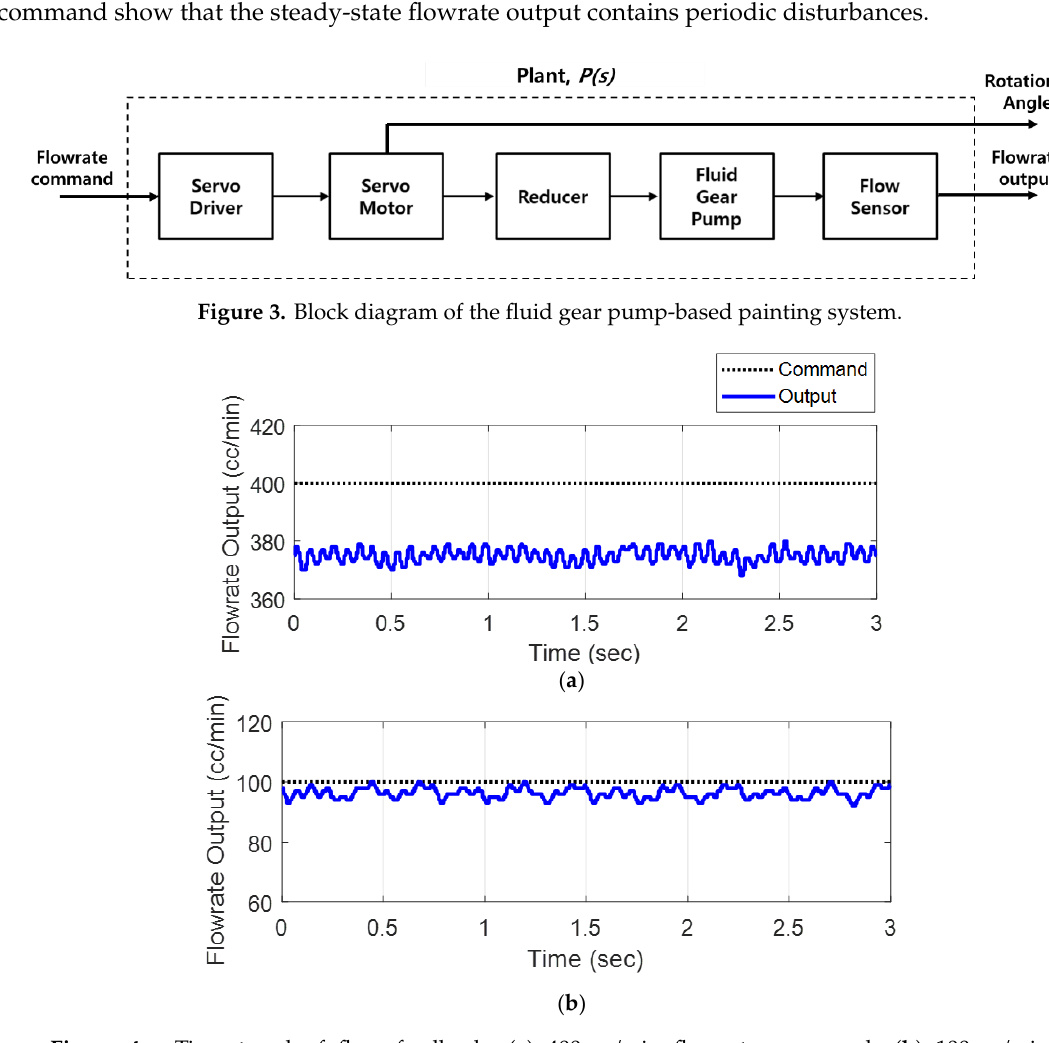
Figure 4. Time trend of flow feedback; ( a ) 400 cc/min flowrate command; ( b ) 100 cc/min flowrate command.